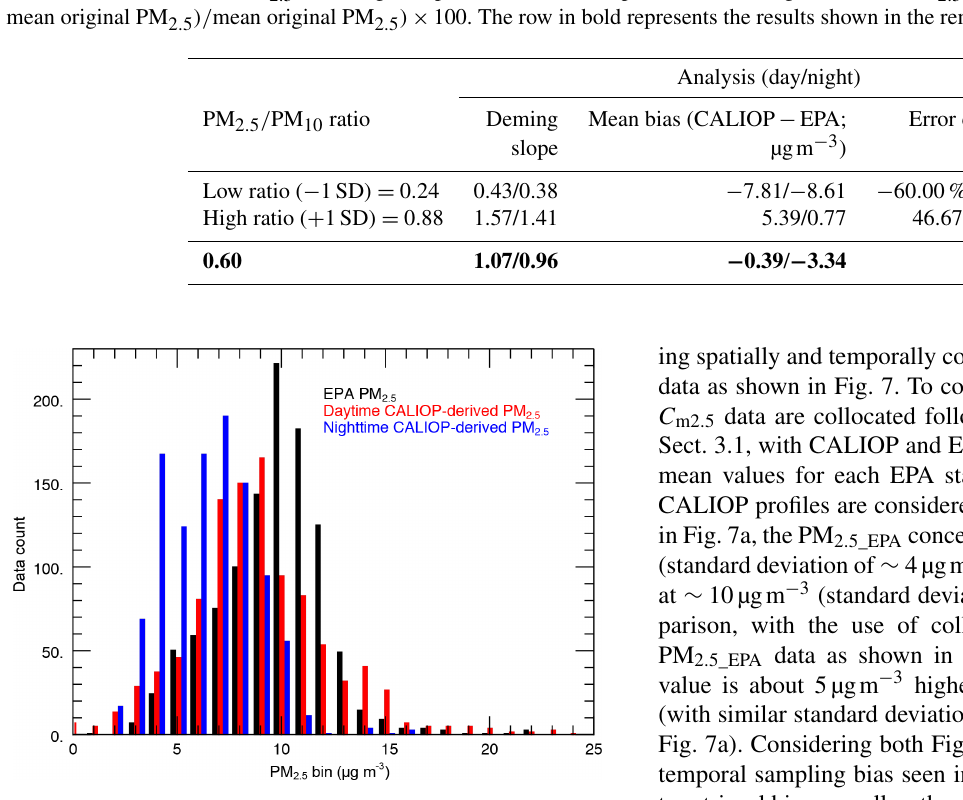
Table 3. Statistical summary of a sensitivity analysis varying the PM 2 . 5 -to-PM 10 ratio used, including slope from Deming regression, mean bias (CALIOP − EPA) of PM 2 . 5 in micrograms per cubic meter, and percent error change in derived PM 2 . 5 , defined as (( mean new PM 2 . 5 −